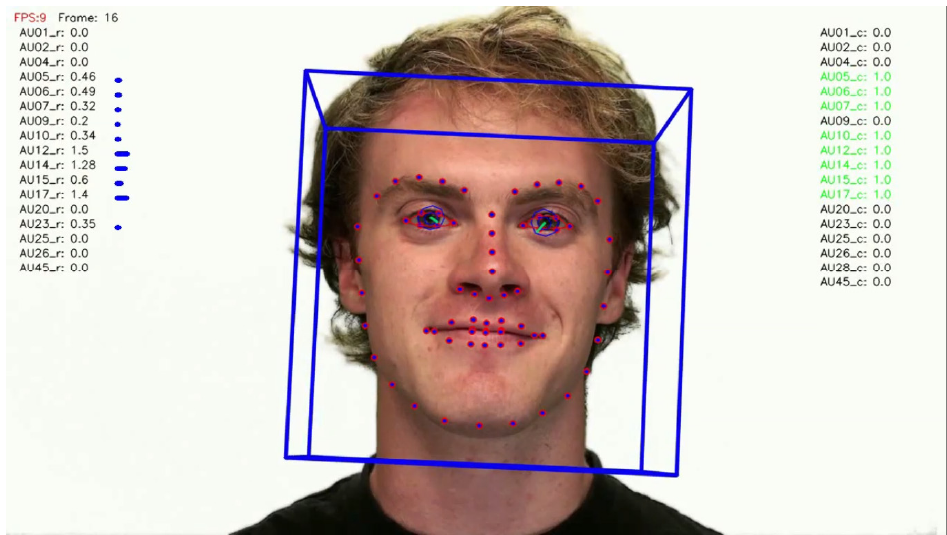
Figure 10. Facial recognition example 2.